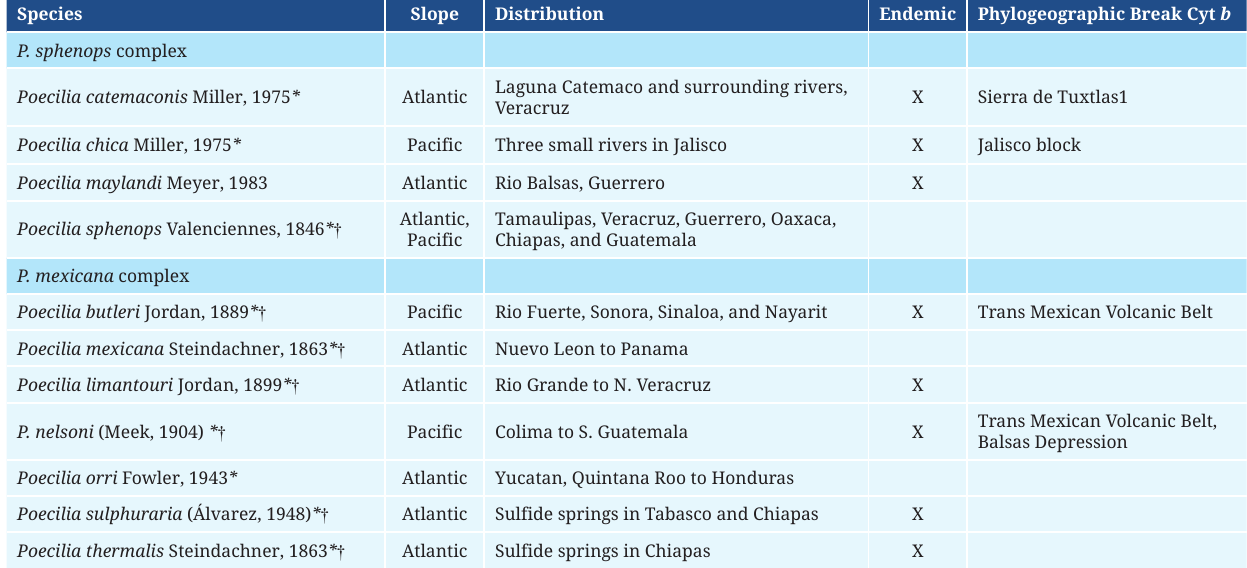
TABLE 1 | List of species from the Poecilia sphenops and P. mexicana species complexes present in Mexico. The table provides information about the slope on which a species occurs, a broad description of the distribution, the endemism status in Mexico, and phylogeographic breaks uncovered in this study. Asterisks indicate the inclusion of a species in phylogenetic analyses; crosses indicate focal species used for phylogeographic analyses based on Cyt b